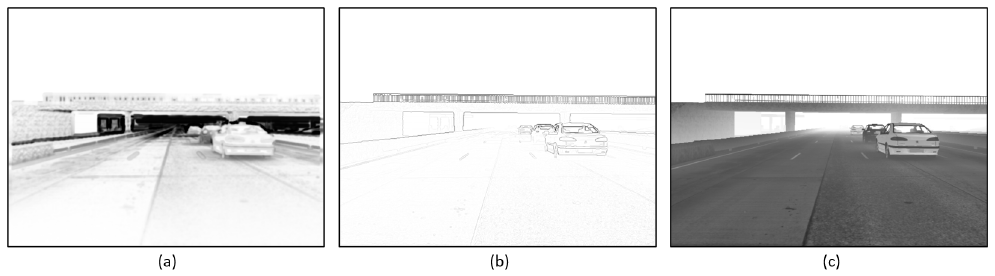
Figure 11. ( a ) SSIM map of a restored image from the FRIDA dataset, ( b ) gradient map, ( c ) inten- sity